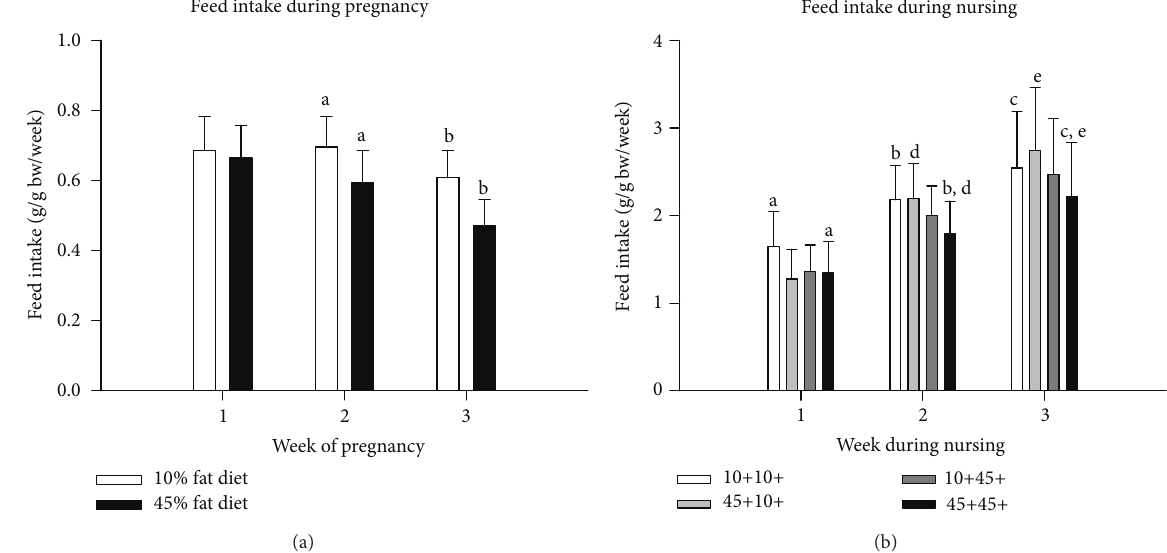
Figure 2: The feed intake of the dams during (a) pregnancy, that is, from mating to the end of week 3 of pregnancy ( 𝑛 = 37 – 119 ), and (b) the three week lactation period ( 𝑛 = 12 – 69 ), recorded as gram diet per gram body weight per week (mean ± SD). During pregnancy, the dams were given either a 10% fat (white columns) or a 45% fat diet (black columns). The data for the lactation period were stratified according to the four different combinations of the 10% fat or 45% fat diet during pregnancy and the 10% fat or 45% fat diets during the lactation period; 10+10+ (white columns), 45+10+ (light grey columns), 10+45+ (dark grey columns), 45+45+ (black columns), as explained in the legend to Figure 1. (a) a , b Significantly higher with a 10% fat diet versus a 45% fat diet within the same week. (b) a , b , c Significantly higher with a 10% fat diet during both pregnancy and nursing periods versus a 45% fat diet in the same periods within the same week. (b) d , e Significantly higher with a 45% fat diet during pregnancy and a 10% fat diet during nursing versus a 45% fat diet in both periods within the same